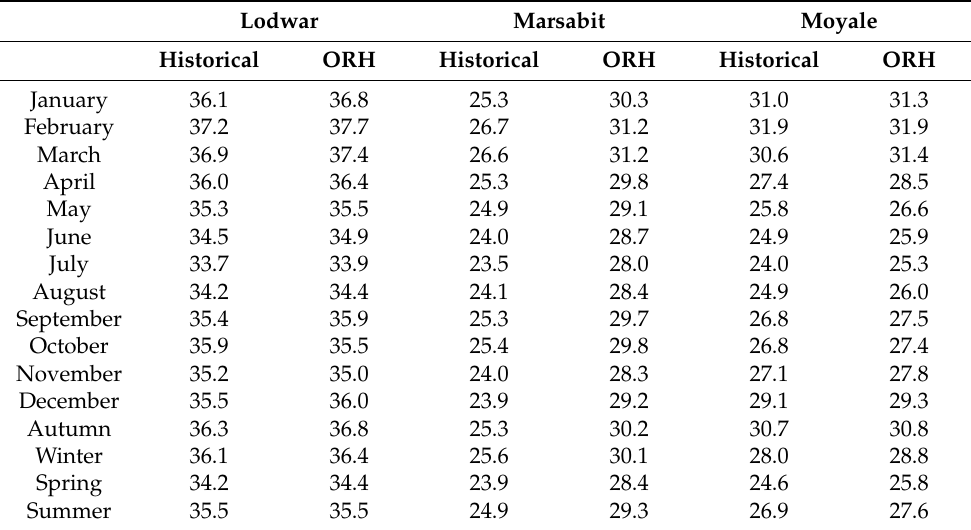
Table A1. Comparison of monthly/seasonal mean value of maximum temperature (values are expressed in ◦ C) obtained from the historical time series and the ORH dataset for the three land- based meteorological stations (Lodwar, Marsabit and Moyale). Lodwar Marsabit Moyale Historical ORH Historical ORH Historical ORH